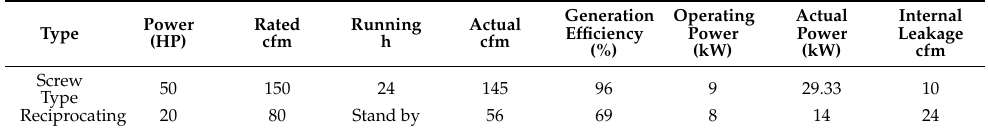
Table 11. Capacity assessment test on air compressors.